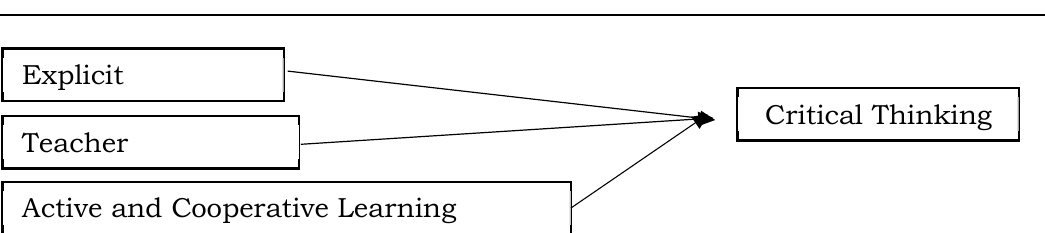
Figure 1. Instructional strategies for critical thinking (Zhao et al.,